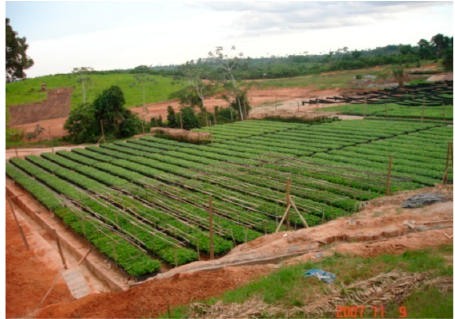
Figure 5. Lateral view of the central nursery.